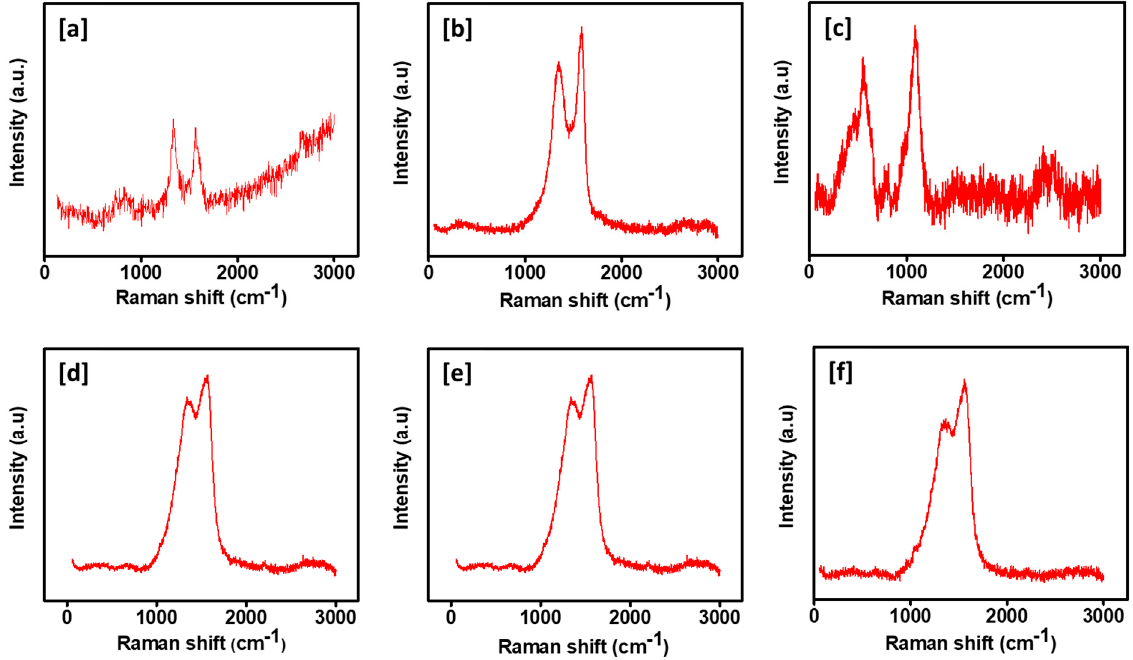
Figure 4. Raman spectra of ( a ) MWCNTs ( b ) GONRs, ( c ) PPy, ( d ) 0.5 PPyGONR, ( e ) 1.5 PPyGONR, and ( f ) 3